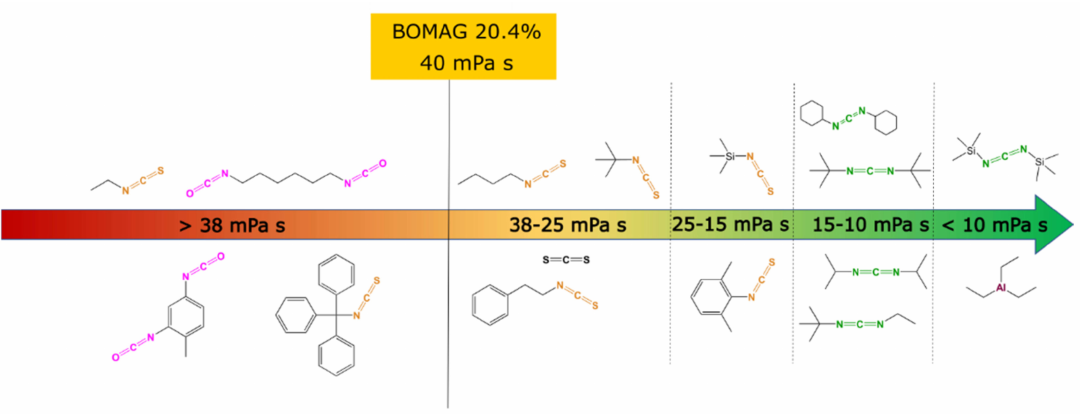
Figure 2. Visualization of the viscosity reduction effect due to the addition of heterocumulenes to a 20.4% butyl octyl magnesium (BOMAG) solution in heptane (mixture of isomers). The concentrations of the additives are listed in Table S1.